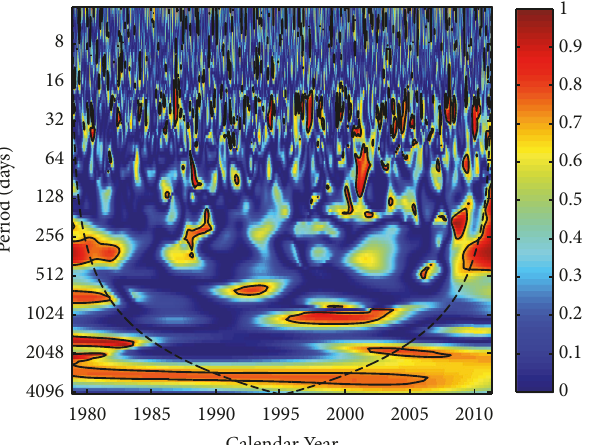
Figure 6: Partial wavelet coherence of the daily TSI and Mg II index (after eliminating the effect of sunspot area). The dashed black line indicates the COI where edge effects might distort the picture, and the 95% confidence level is shown as a thick contour, which is estimated by Monte Carlo